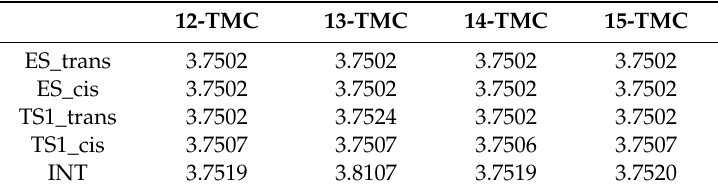
Table 2. Calculated spin contamination (S*2 − S(S + 1)) for all investigated complexes under quartet spin state. TMC indicates the di ff erently sized (12, 13, 14 and 15) N-tetramethylated cyclam chelates.